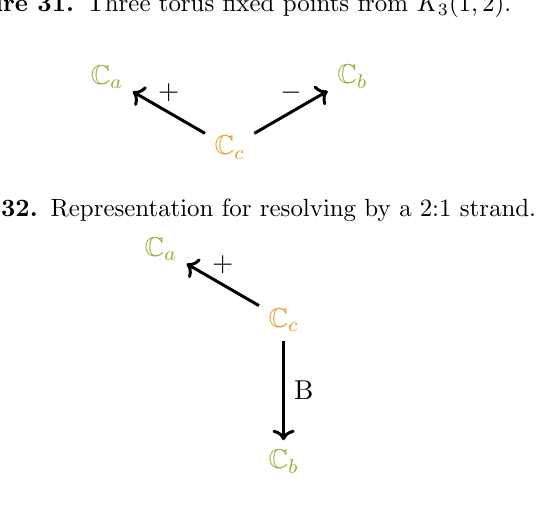
Figure 33. Representation for resolving by a 1:1 strand (++ according to the direction of